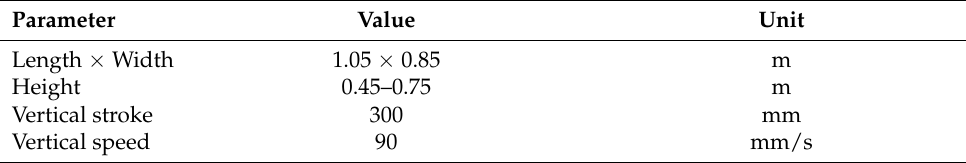
Figure 6. The apron is used to simulate a heaving vessel deck. Table 3. Parameters of the